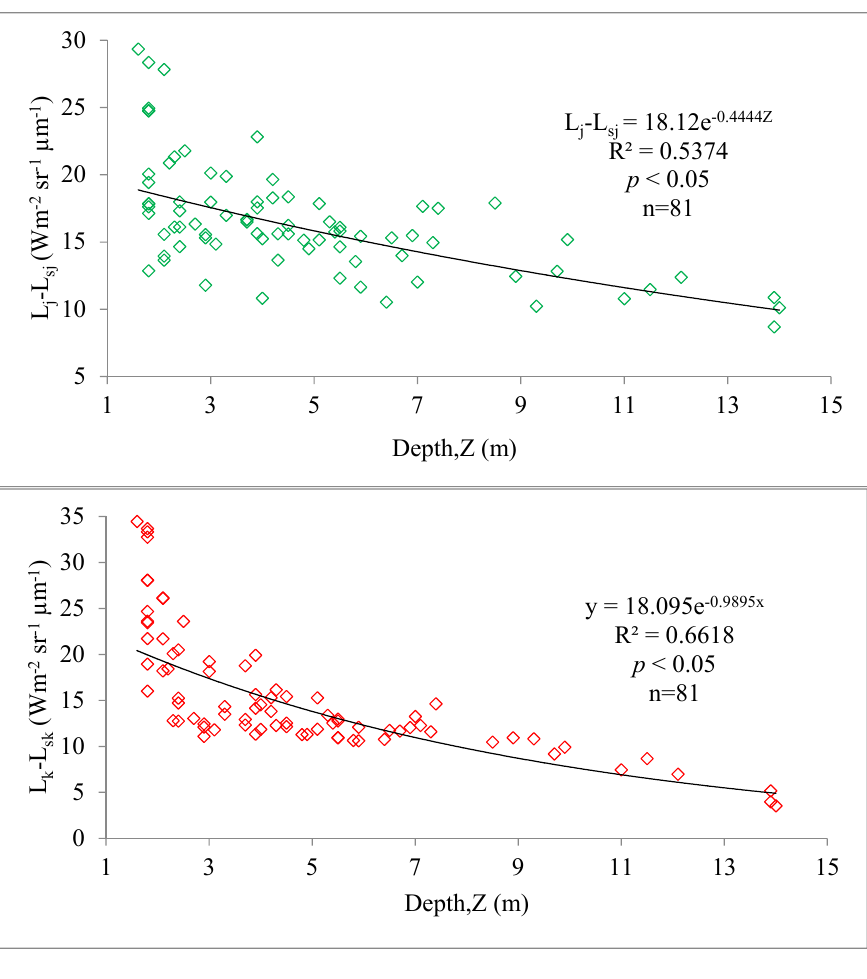
Figure A2. The attenuation coefficient of blue, green and red OLI band.